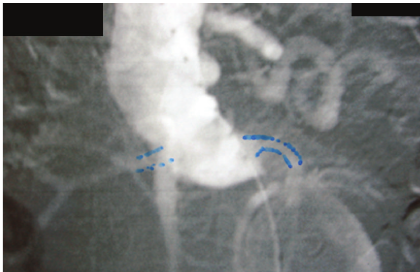
Figure 1: DSA arteriography that shows the short and angulated neck of the AAA.